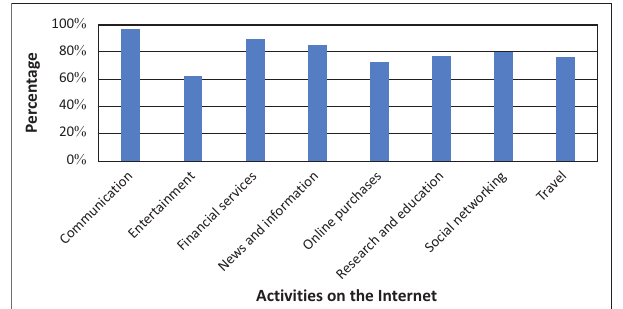
FIGURE 3: Respondents are active Internet users.